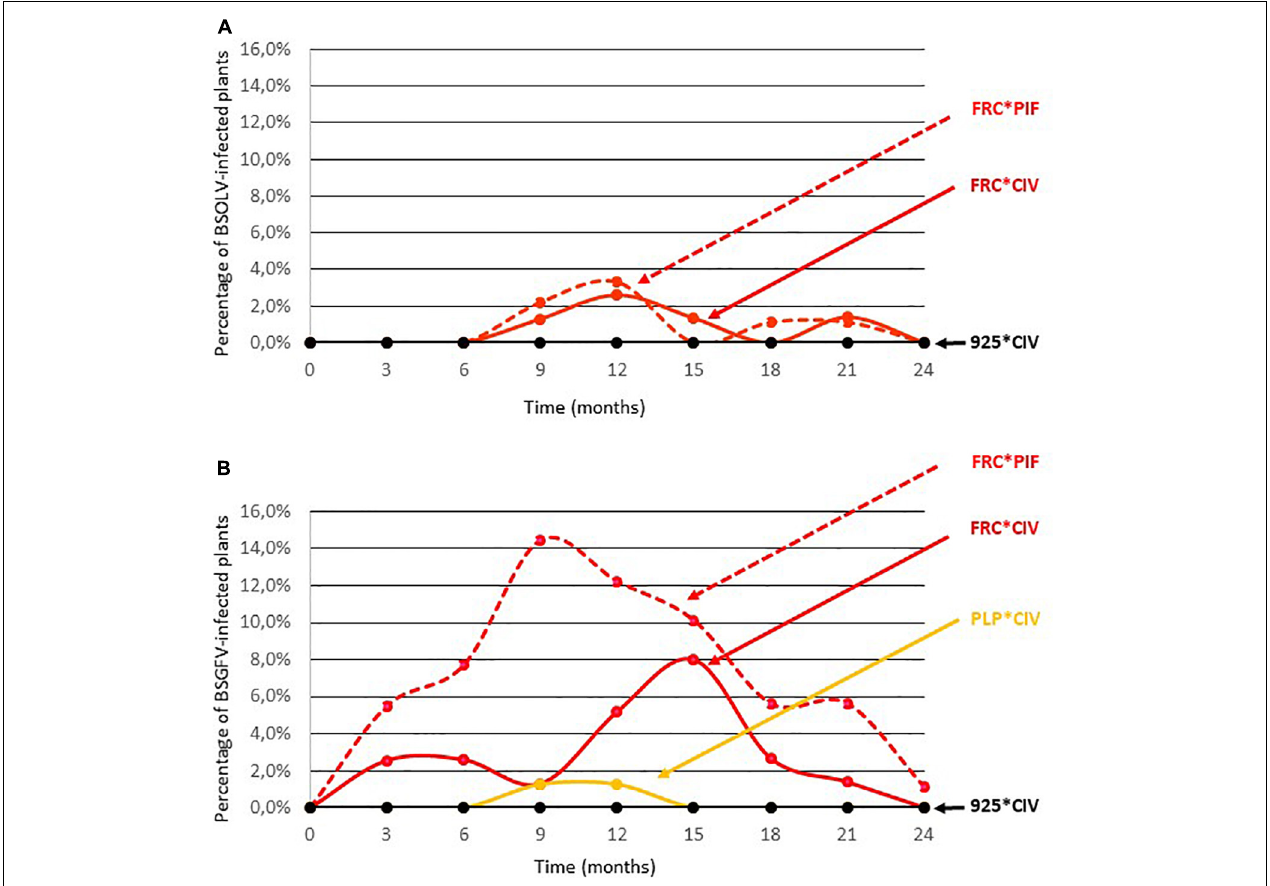
FIGURE 2 | Kinetics of activation of eBSOLV (A) and eBSGFV (B) infectious alleles during the field trial in plants of cultivars French Clair (FRC) and Pelipita (PLP) originating from cell culture ( ∗ VP) or horticultural multiplication ( ∗ PIF). Cultivar Flhorban 925 was used as a negative control of